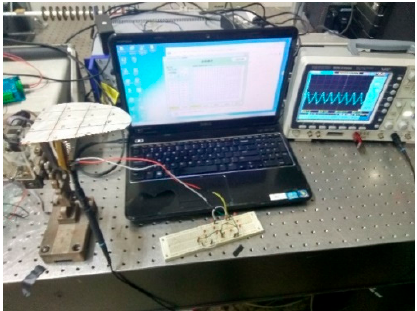
Appl. Sci. 2021 , 11 , x FOR PEER REVIEW Figure 15. LED light supply experimental device. Figure 15. LED light supply experimental device.